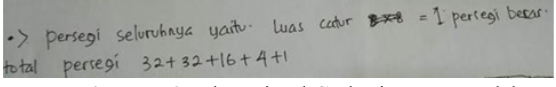
Figure 6. The Final Solution to Problem Number 1 by S2